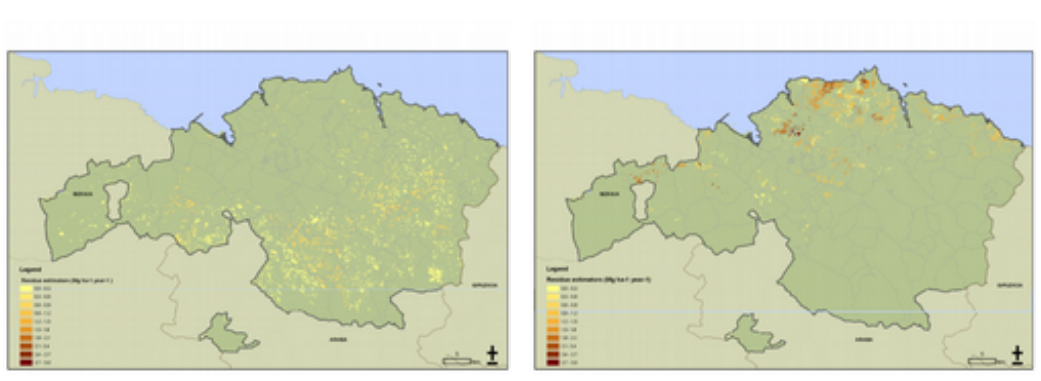
Figure 5. Annual WL estimators ( E r , Mg ha − 1 year − 1 ) Figure 4. Annual WL estimators ( E r , Mg ha −